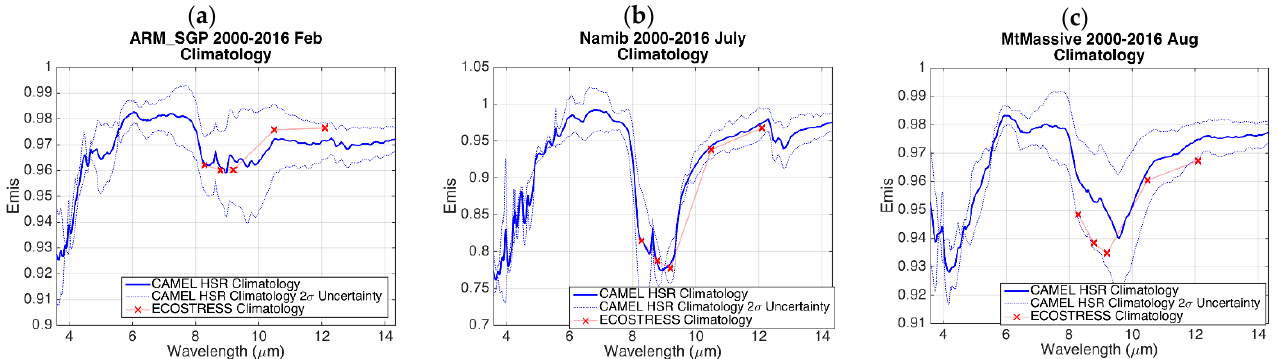
Figure 12. CAMEL HSR climatology (solid blue line) with the 2 sigma uncertainty estimate (dotted blue lines) overlaid by ECOSTRESS (red crosses) emissivity. ECOSTRESS follows the CAMEL climatology very closely over ( a ) ARM SGP in the month of February, and ( b ) the Namib site in the month of July. At ( c ) Mt. Massive, ECOSTRESS emissivity is significantly lower than the CAMEL climatology, potentially due to small changes in landcover over a heterogeneous site, since the two measurements do not overlap temporally.